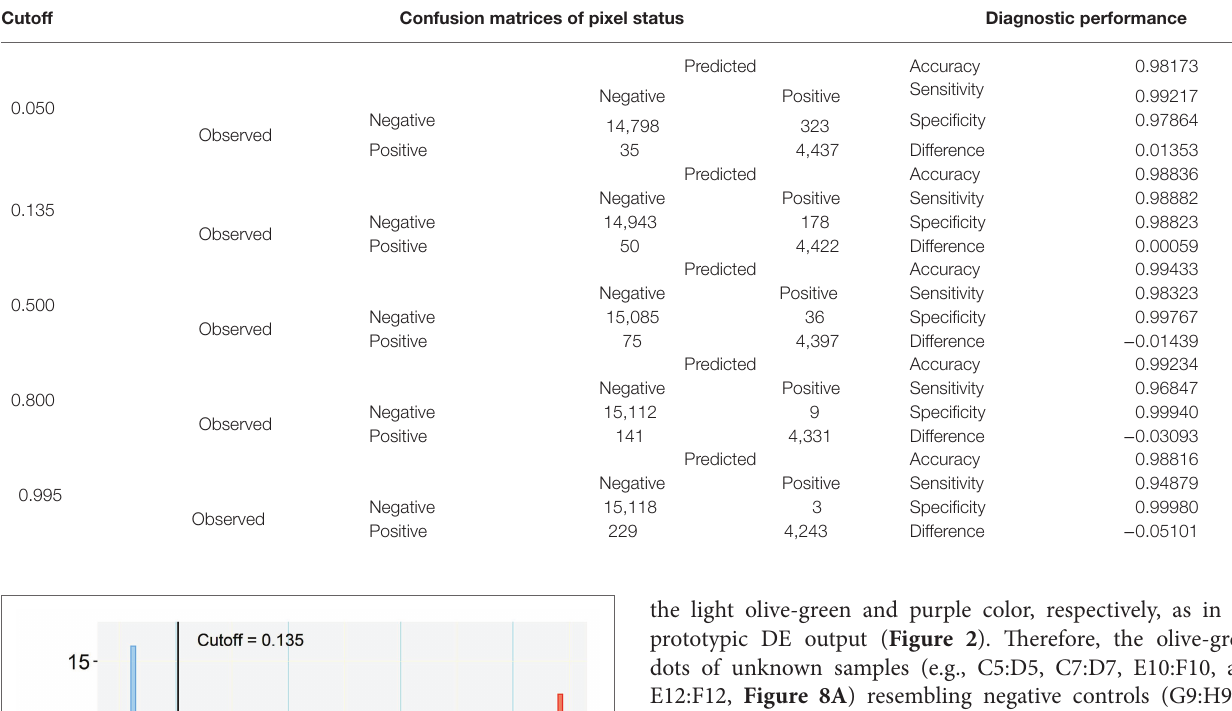
the light olive-green and purple color, respectively, as in the prototypic DE output ( Figure 2 ). Therefore, the olive-green dots of unknown samples (e.g., C5:D5, C7:D7, E10:F10, and E12:F12, Figure 8A ) resembling negative controls (G9:H9 to G12:H12) could be classified rather easily as virus-free. However, most dots of unknown samples displayed different shades of purple, ranging from cyclamen to deep violet. Some dots were lighter (e.g., C4:D4 and E4:F4), comparable (e.g., A12:B12 and C12:D12), or darker (e.g., A1:B1, A2:B2, E8:F8, and E9:F9) than the positive controls, rendering infection status determination by eye-based comparison uncertain. Application of our trained and validated algorithm cleared up the confusion. After matrix conversion and pixel probability prediction, the DE image of unknown samples was reconstituted at various cutoffs ( Figures 8B-F ), revealing truly positive samples with a very high probability of success. Positive controls produced a robust signal throughout the range of examined cutoffs, while negative controls did not produce a signal at any considered cutoff value, as was the case for the Buffer alone negative controls.